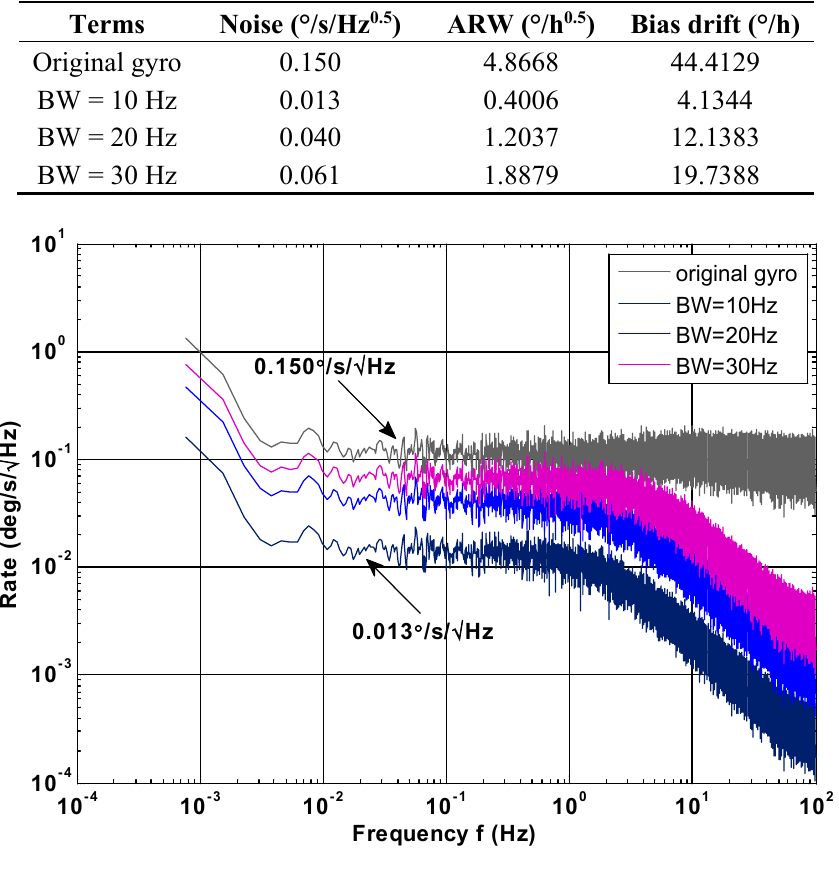
Figure 4. FFT of the gyroscope rate signal under different KF bandwidths.